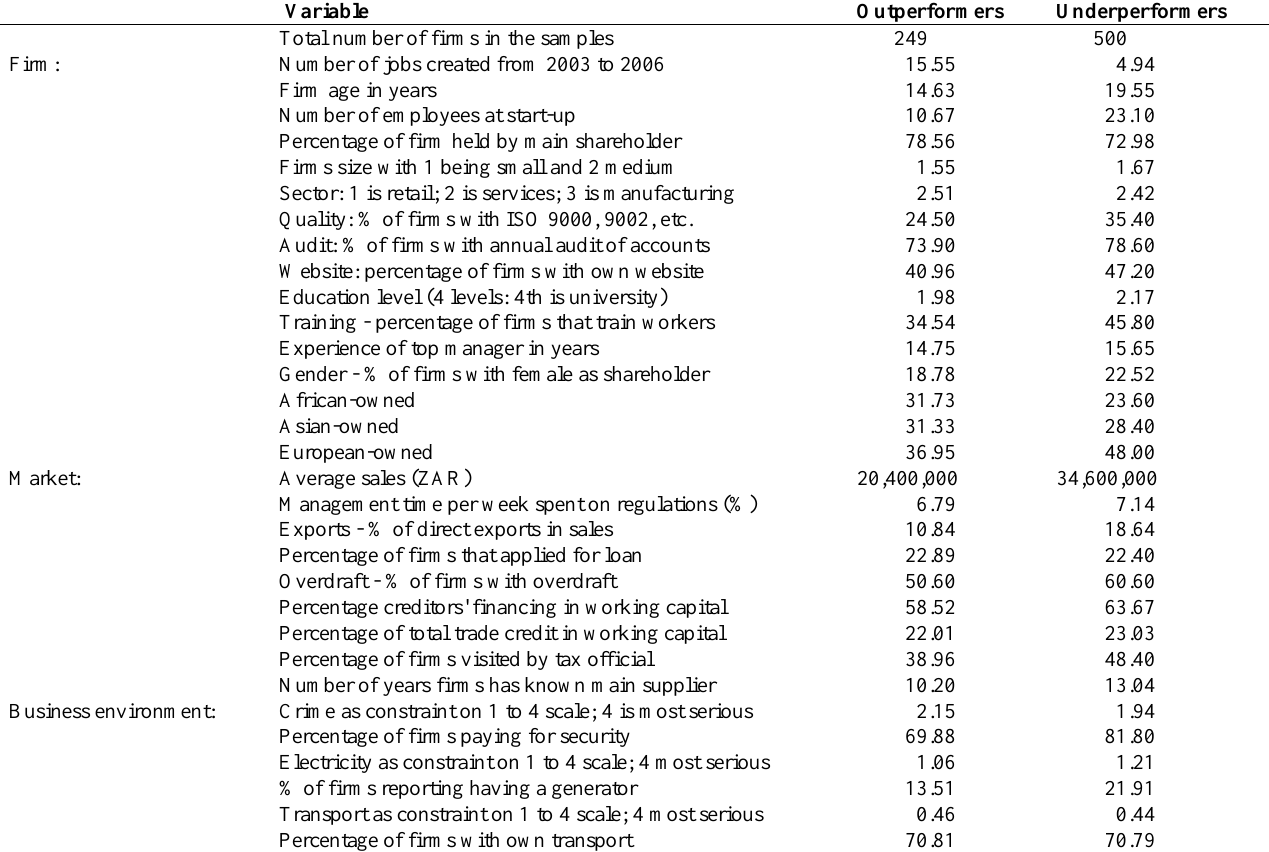
Table 1: Outperformers vs. underperformers – comparing means of characteristics